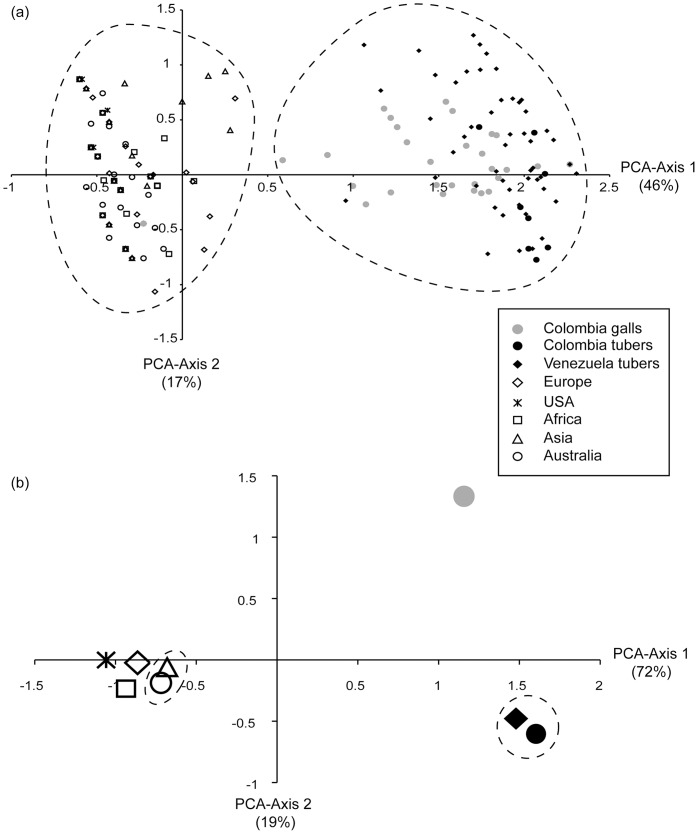
Principle Component Analyses (PCA) of Spongospora subterranea f.sp. subterranea multilocus genotypes.The analyses based on covariances of allele frequencies. (a) PCA performed on individuals resulted in axis 1 explaining 46% and axis 2 explaining 17% of the genetic variation. The dashed lines encircle the two clusters identified by K-means clustering. (b) PCA performed on regions resulted in axis 1 explaining 72% and axis 2 explaining 19% of the genetic variation. The dashed lines encircle regions that are not differentiated based on FST analysis.